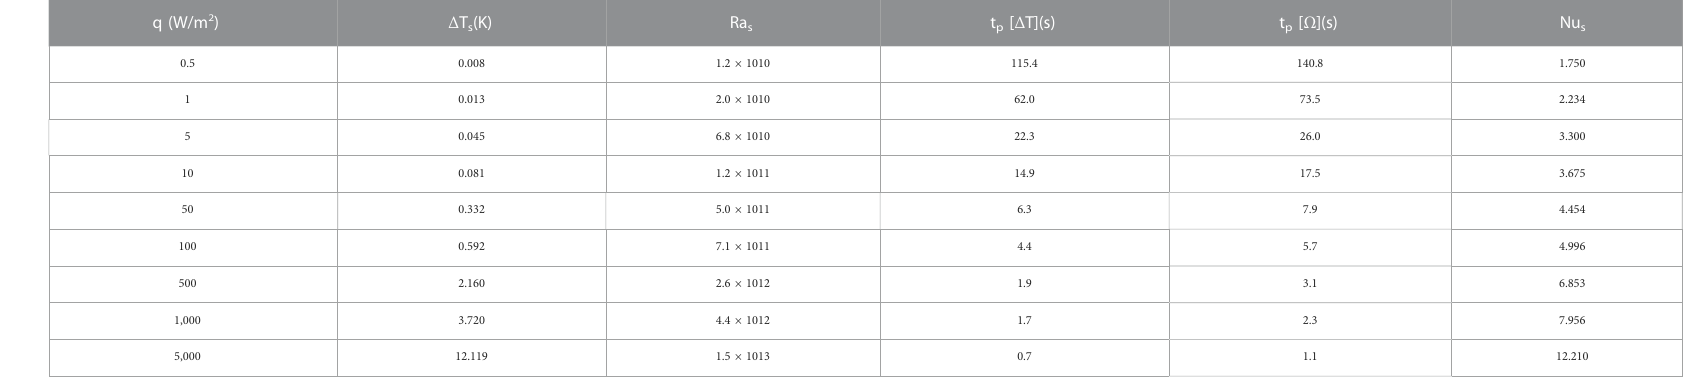
TABLE 2 Calculations of the various fl uid dynamic and heat transfer properties of the RB convection with nine different bottom heat fl uxes. q (W/m 2 ) Δ T s